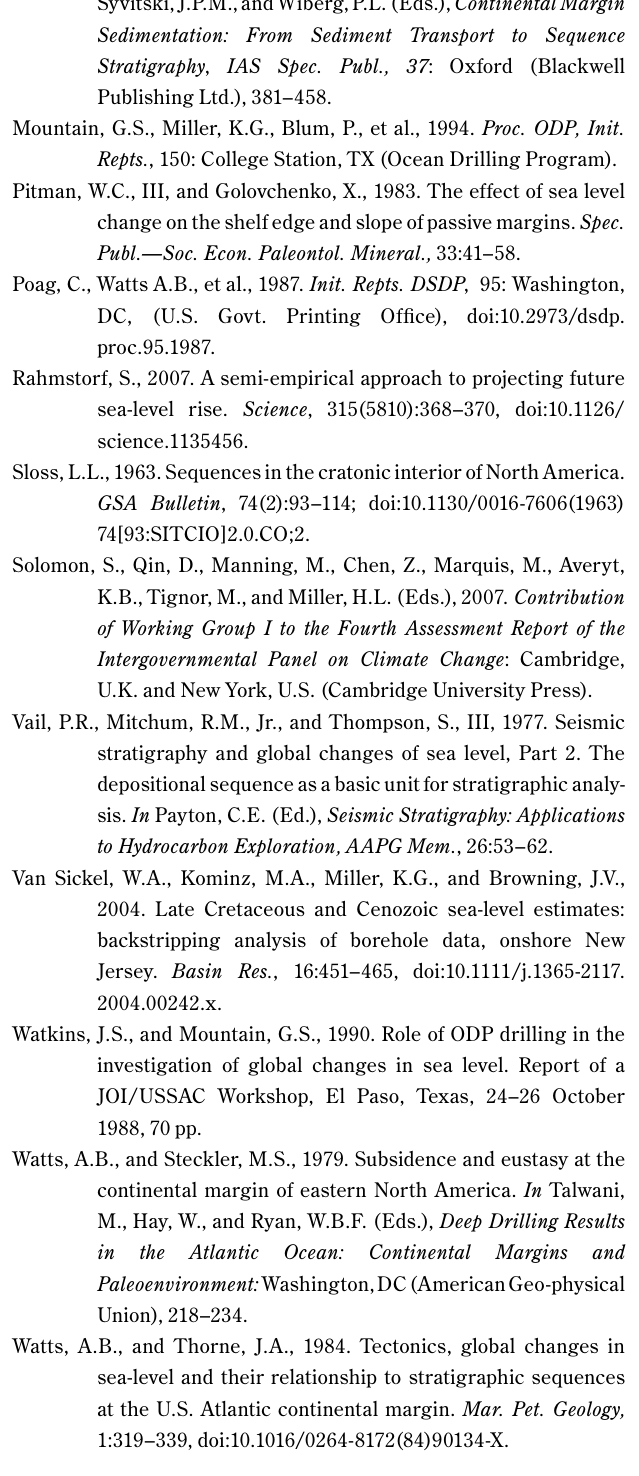
Figure 2. photo cortesy of ESO/IODP Figure 5. by Gregory